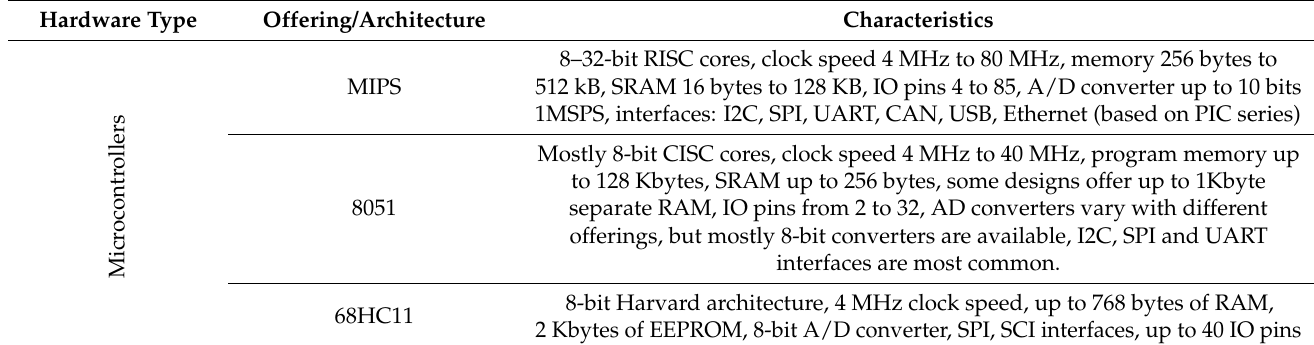
Table 7. Computation platforms for IoT